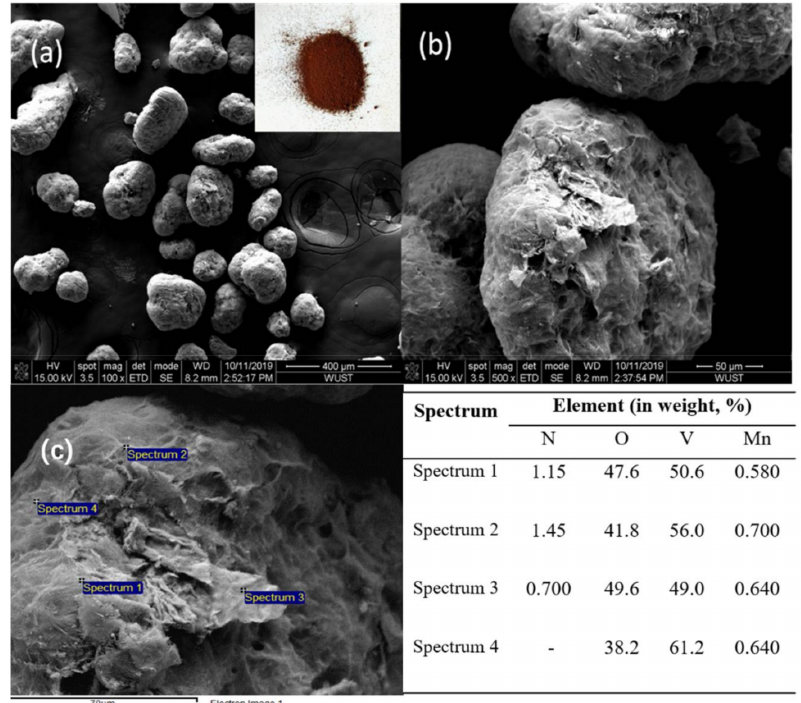
Figure 17. SEM-EDS analysis for vanadium precipitation, ( a ) magnification × 100, ( b ) magnification × 500, ( c ) magnification × 1000.